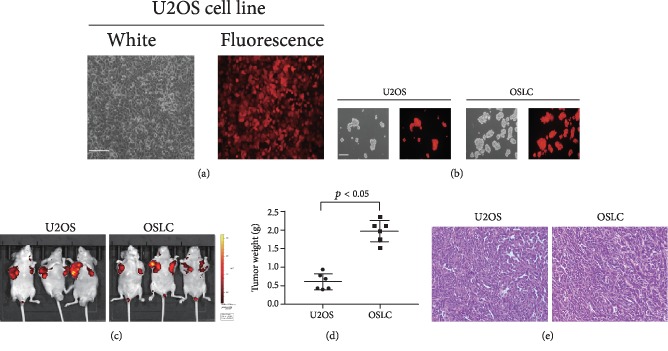
Comparison of carcinogenicity in vivo between U2OS cells and OSLCs. (a) Fluorescence microscopy image of U2OS cells that stably express red fluorescent protein (RFP, scale bar, 100 μm). (b) Fluorescence microscopy image of the spheres derived from U2OS cells and OSLCs that stably express RFP (scale bar, 100 μm). (c) Images of subcutaneous xenografts inoculating U2OS cells (2 × 105, injected into the left flank) or the corresponding OSLCs (2 × 103, injected into the right flank), which express RFP. (d) Comparison of the growth of xenografts from U2OS cells expressing red RFP (2 × 105) and the corresponding OSLCs (2 × 103). ∗p < 0.05 vs. U2OS cells. Data were obtained from xenografts weighing results at 6 inoculated sites (n = 6). (e) Comparison of histological morphology of xenografts between U2OS cells (2 × 105) and U2OS-derived OSLCs (2 × 103). Images of HE staining under an optical microscope (scale bar, 100 μm).